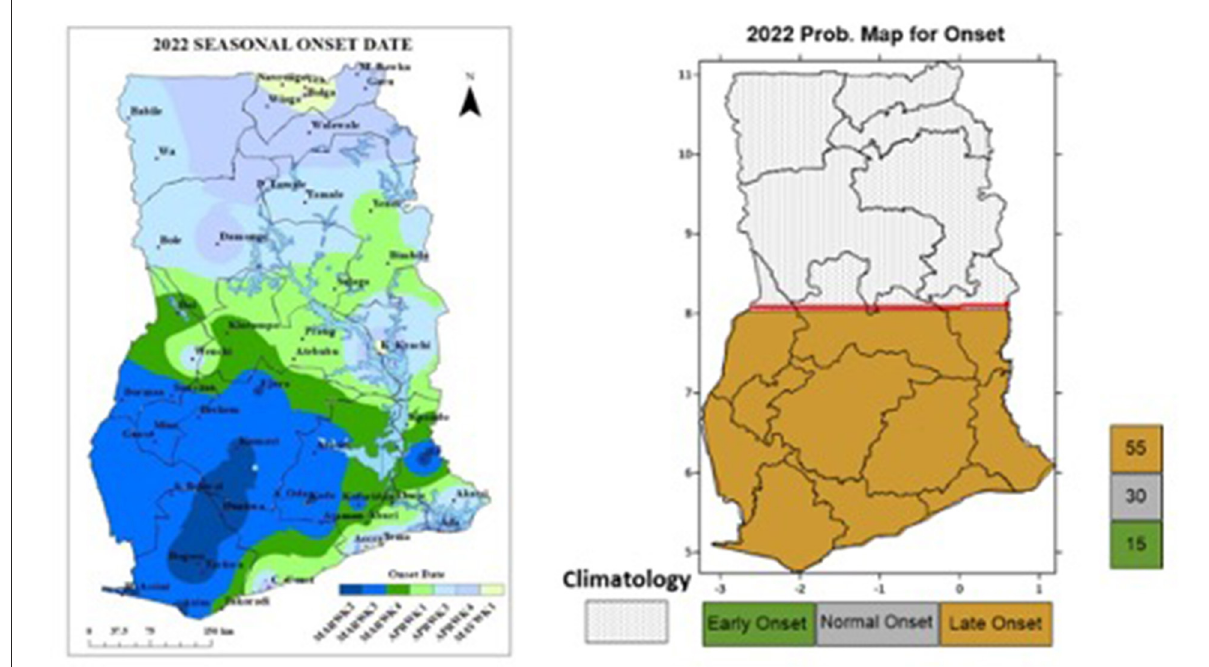
FIGURE1 Example NHMS plot of predicted rainfall season onset. The left plot maps the predicted start to the rainy season from March week 2 (MARWK2) to May week 1 (MAYWK1). The right plot displays the probability of early or late onset, compared to the climatological norm. The bulletin was issued on 9th March 2022 by the Ghana Meteorological Agency (https://www.meteo.gov.gh/gmet/download/10773/?wpdmdl=10773&refresh= 62a74034638d11655128116, retrieved 13th June